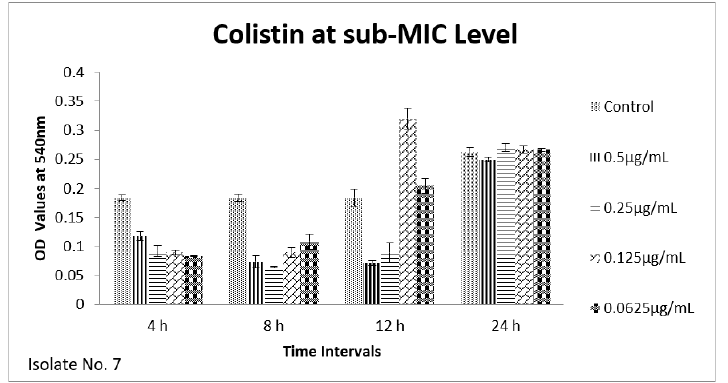
Figure 7. Shown are the effects of colistin on E. coli biofilm at different time points (OD 540 nm). Bar graph represents highest biofilm formation at 24 h of incubation.